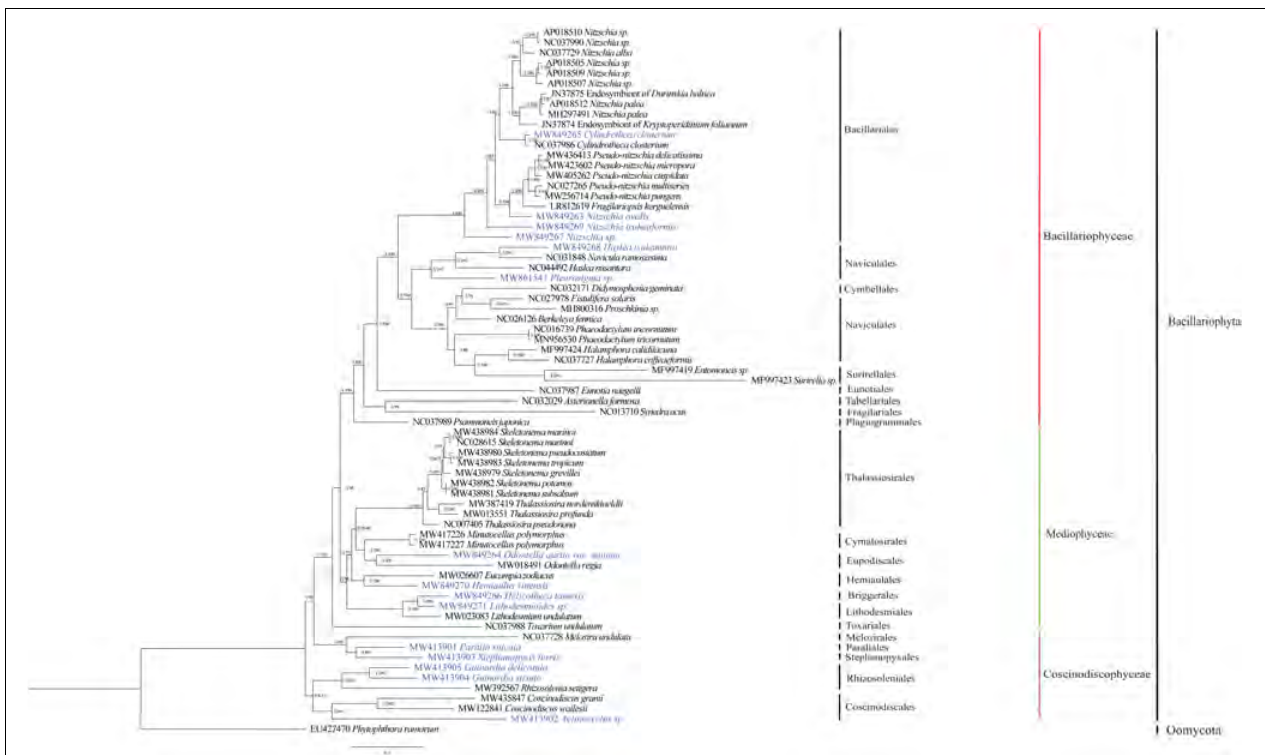
FIGURE 5 | Maximum likelihood (ML) phylogenetic tree based on concatenated amino acid sequences encoded by 27 mitochondrial protein-coding genes ( atp6, 8, 9; cob; cox1, 2, 3; nad1-7, 4L, 9, 11; rpl2, 6, 14, 16; rps3, 4, 8, 11, 14; and tatC ). Mitochondrial protein-coding genes of Phytophthora ramorum were used as outgroup taxa. Numbers on the left and right side at the branches represent Bayesian posterior probabilities and bootstrap values. Branch lengths were proportional to the amount of sequence change, which are indicated by the scale bar below the